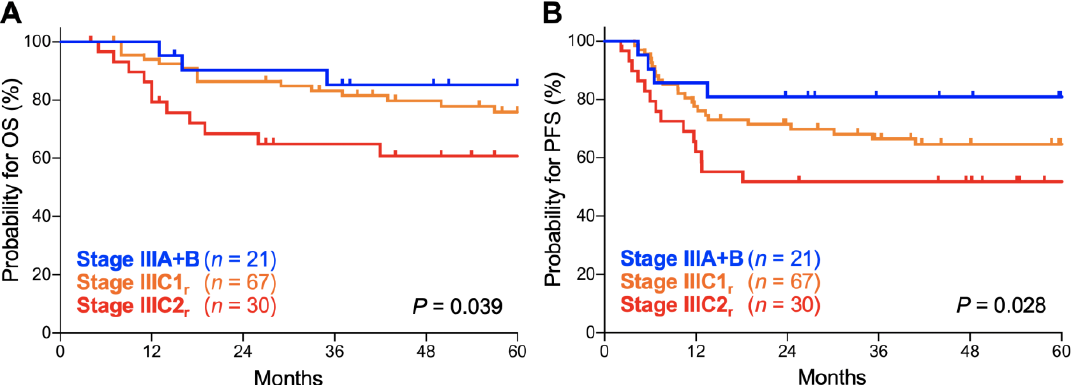
Figure 4. Kaplan–Meier estimates of overall survival (OS) ( A ) and progression-free survival (PFS) ( B ) for stage III patients with squamous cell carcinoma of the cervix according to the International Federation of Gynecology and Obstetrics (FIGO) 2018 staging criteria. p values calculated from the log-rank test for trend are shown. Table 4. Outcomes of FIGO 2018 Stage III patients with squamous cell carcinoma of the uterine cervix.